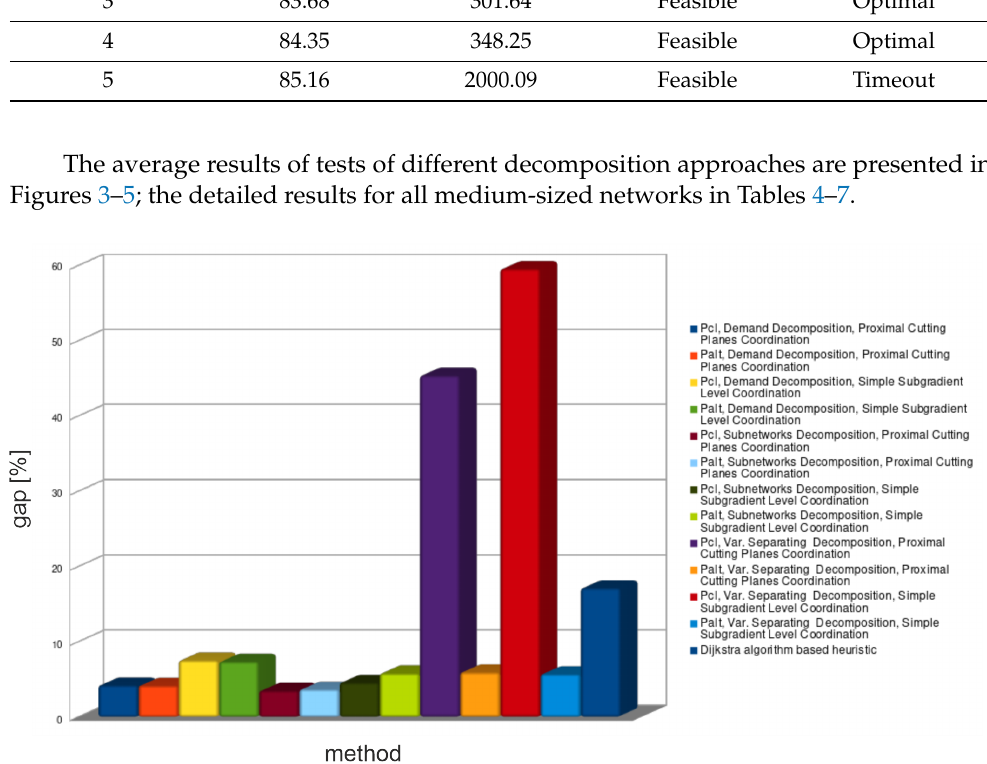
Figure 3. Average lower bound relative gap for all decomposition methods—medium